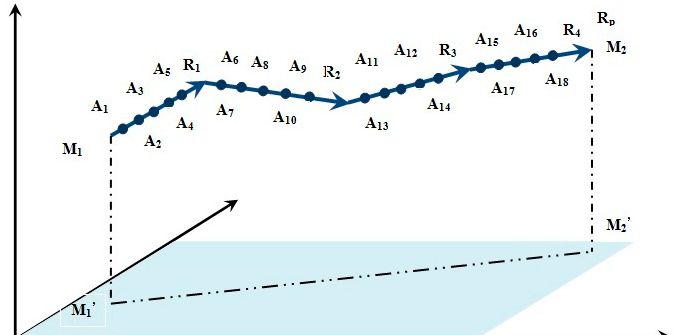
Figure 4. Flight path.